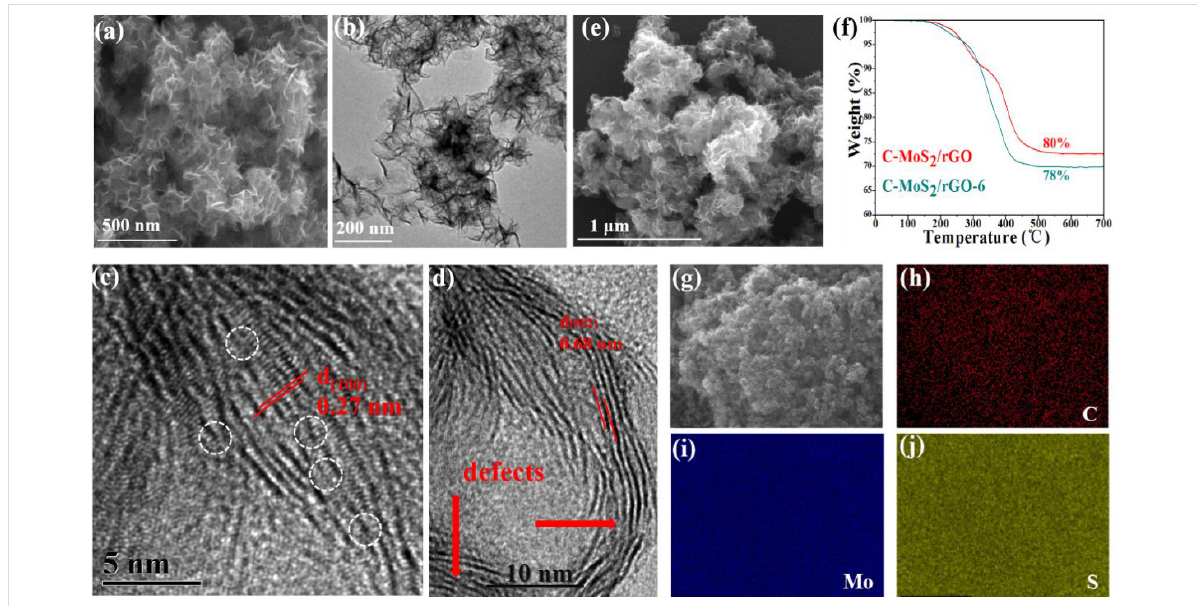
Figure 3: Morphological images of the annealed C-MoS 2 /rGO-6 composite: (a) SEM; (b) TEM; (c, d) HRTEM; (e) SEM image of C-MoS 2 /rGO-6-S; (f) TG analysis curve; (g–j) element mapping images of Mo, S, and C.